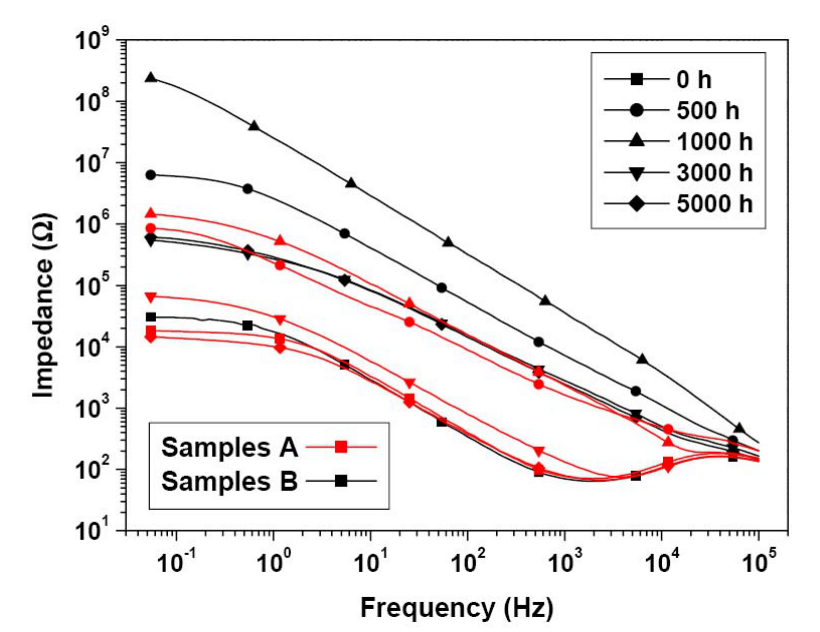
Figure 12. EIS Bode plot of samples A and B before and after different periods of oxidation at 1,273